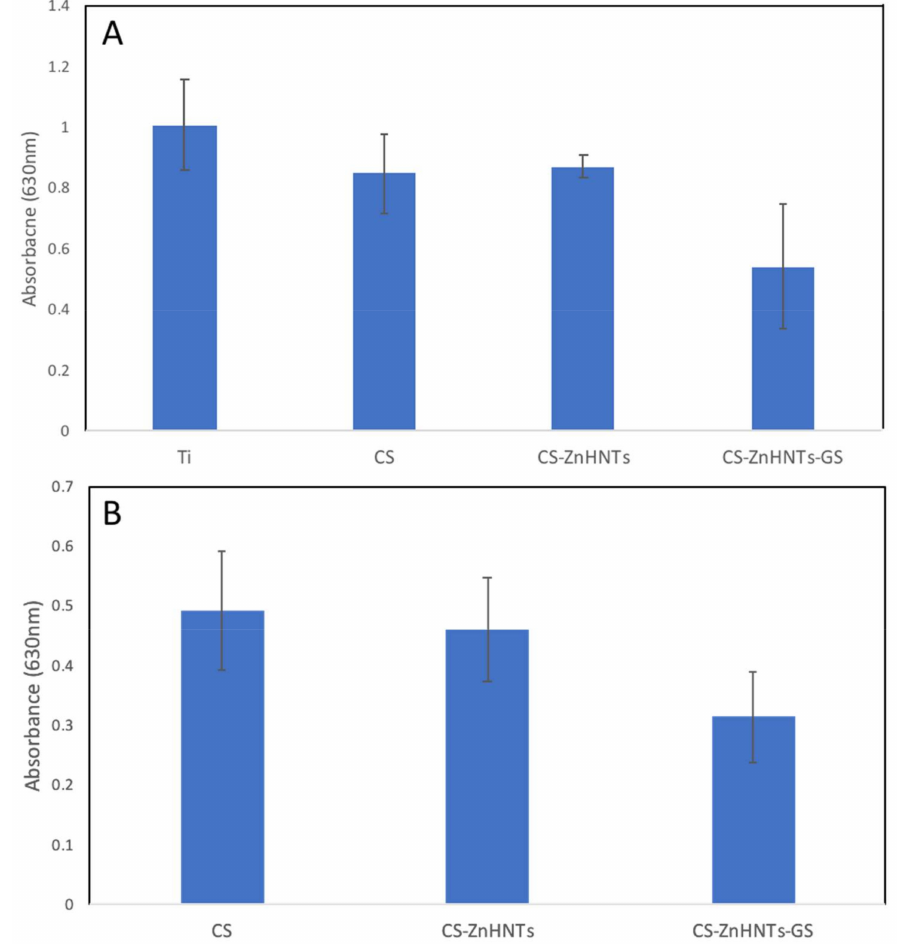
Figure 9. ( A ) Bacterial adherence assay using S. aureus applied to the surface of the samples. ( B ) Biofilm assay using crystal violet.